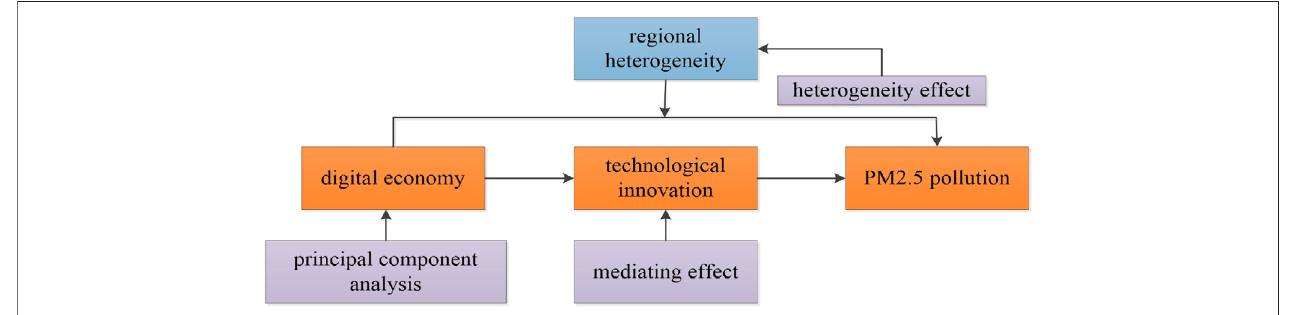
FIGURE 1 | Research framework of digital economy affecting PM2.5